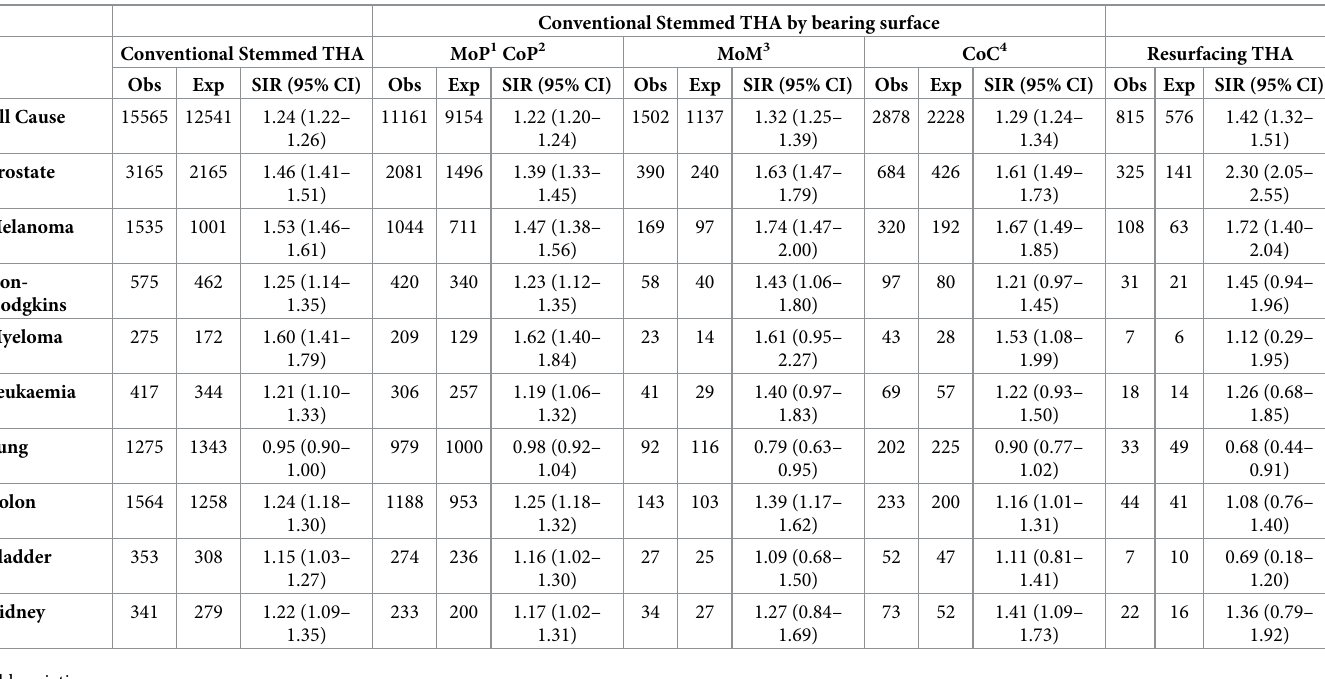
Table 2. Standardised incidence ratios for primary cancer diagnoses for patients receiving a conventional stemmed Total Hip or Resurfacing Hip arthroplasty for osteoarthritis between 1999 and 2012. Expected numbers of cancer cases are approximated from the incidence rate of cancer for the general Australian population. Conventional Stemmed THA by bearing